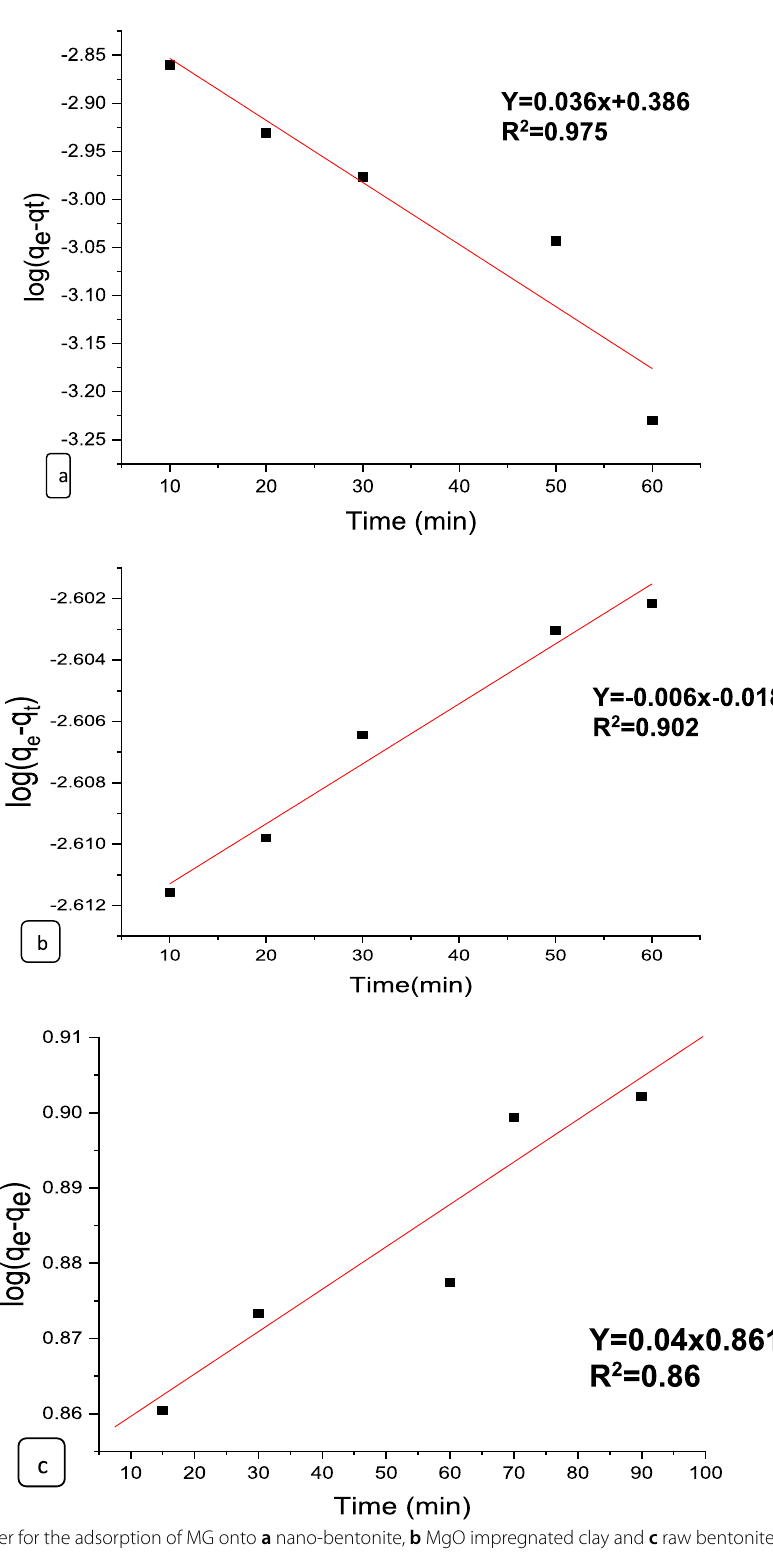
Fig. 14 Pseudo-first order for the adsorption of MG onto a nano-bentonite, b MgO impregnated clay and c raw